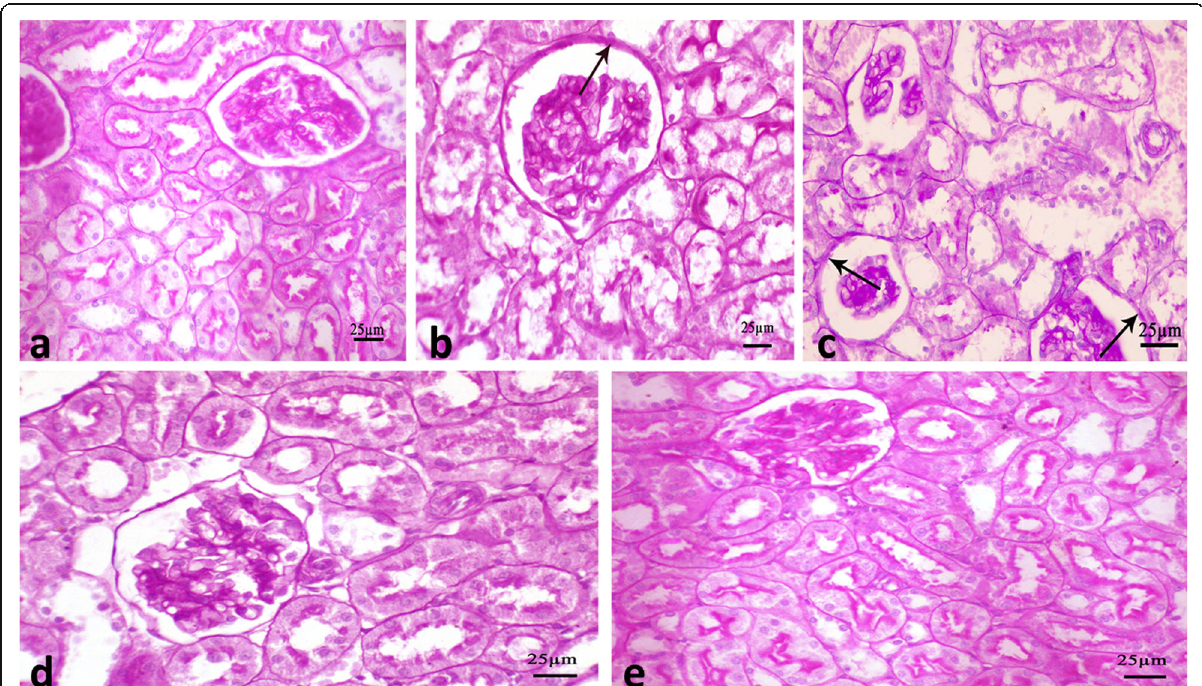
Fig. 5 PAS-stained renal cortex sections at magnification × 400, bar 25 μ m. a Control group showing positive reaction for PAS in glomeruli and tubules with thin basement membranes. b Diabetic nephropathy (DN) group showing diffuse thickening of tubular and glomerular basement membrane (arrows). c Fibroblast group showing diffuse thickening of basement membrane of glomeruli (arrows) and tubules. d AD-MSCs group and e culture medium (CM) group showing relatively thin basement